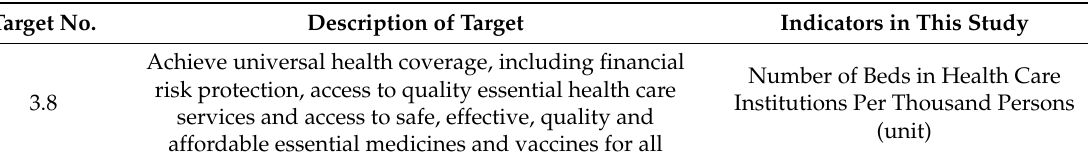
Table 1. Descriptions of indicators and related SDG